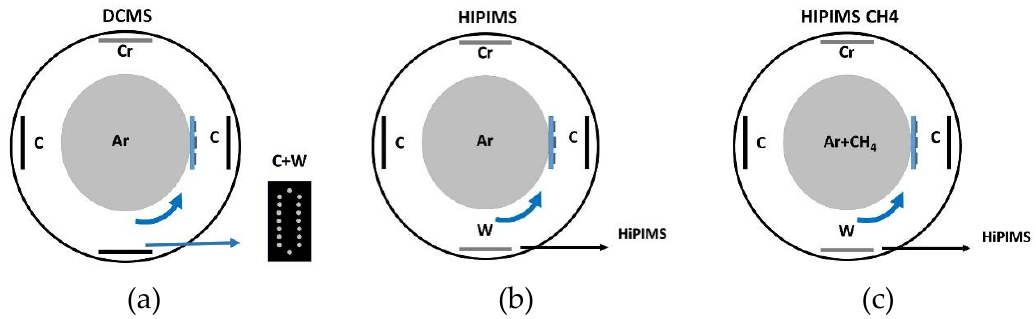
Figure 2. Schematic illustration of the deposition chamber and distribution of targets used for the films deposited for this work, ( a ) DCMS, ( b ) HIPIMS and ( c ) HIPIMS CH4.